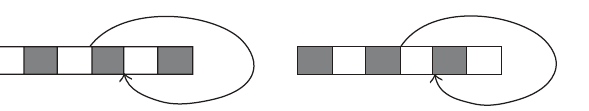
Figure 4: Two isles of Eden are shown, where | x | (cid:7) 6.